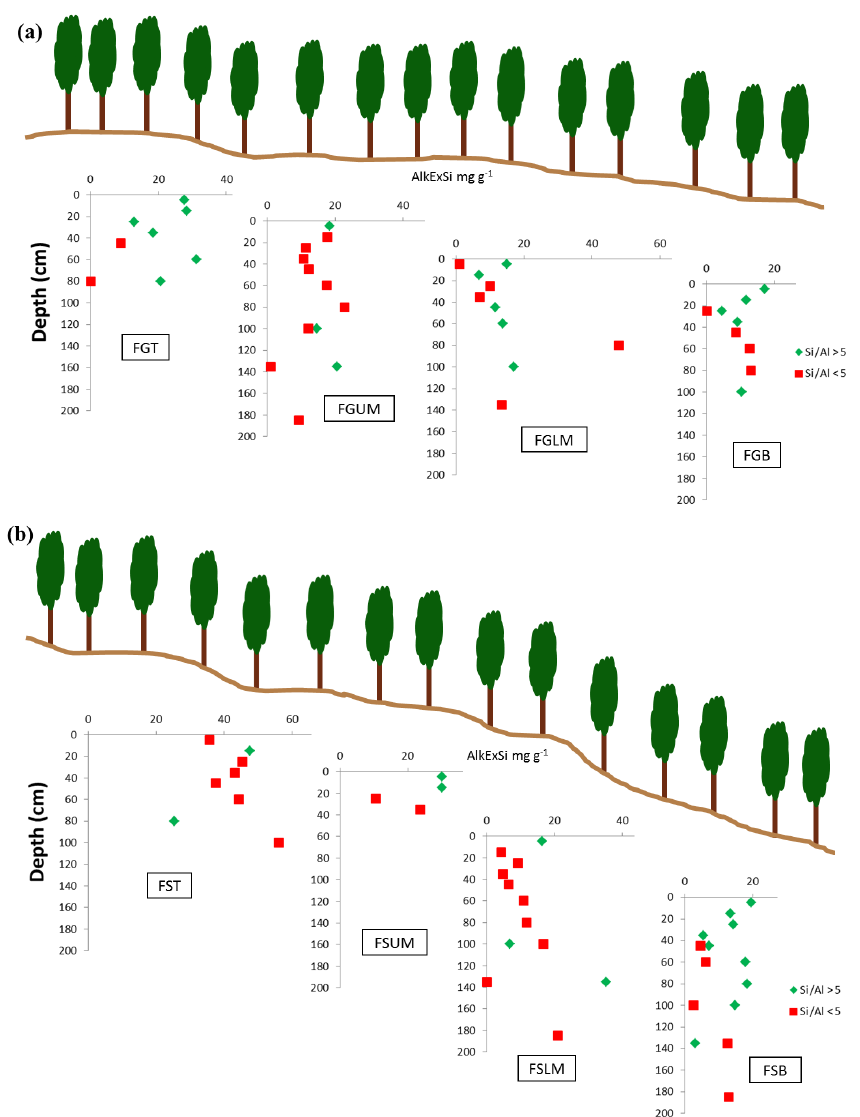
( + 35 % for the biogenic AlkExSi pool and + 85 % for the non-biogenic AlkExSi